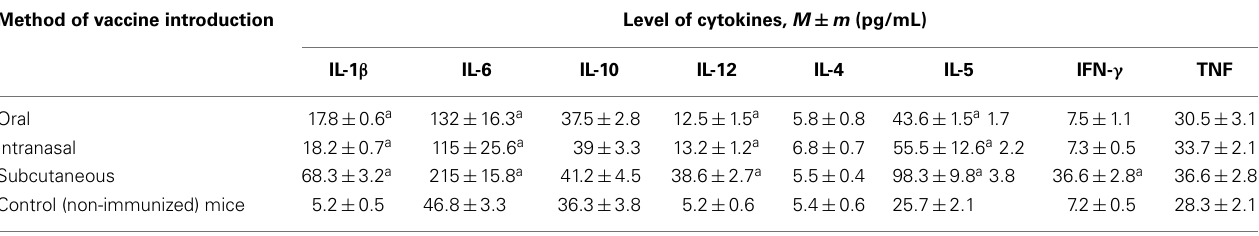
Table 3 | Level of cytokines in mice sera after single injection of immunovac-VP-4. Method of vaccine